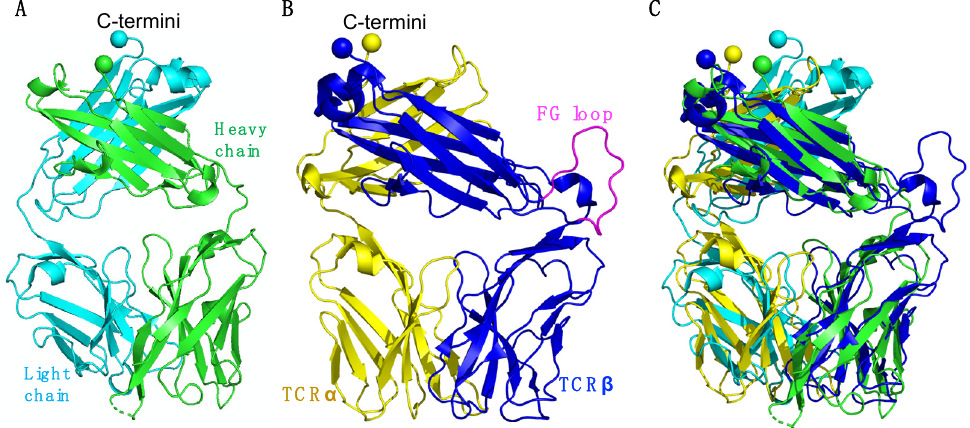
Figure 7. Structural comparison of the Fab and TCR. ( A ) Overall view of a Fab (PDB code: 4XAW). The Fab heavy chain is shown in green and the light chain in cyan. ( B ) Overall view of a TCR (PDB code: 1OGA). The TCR α chain is shown in yellow, the heavy chain in blue, and the TCR β chain FG loop is shown in magenta. ( C ) Structural alignment of Fab and a TCR. ( A – C ) C-terminal residues of each chain are displayed as spheres.